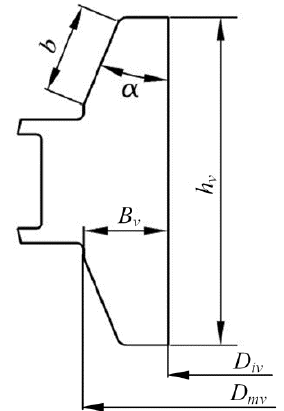
Figure 2. The basic structure of the VX gasket.